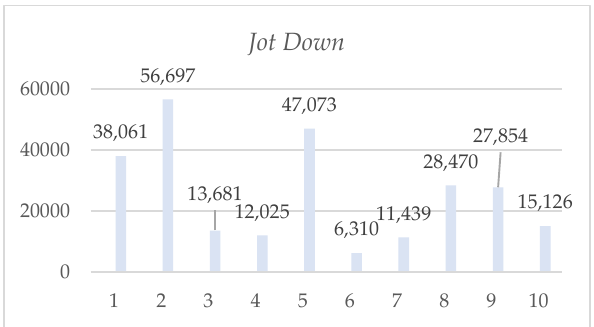
Figure 9. Length of articles on religion studied in Jot Down .